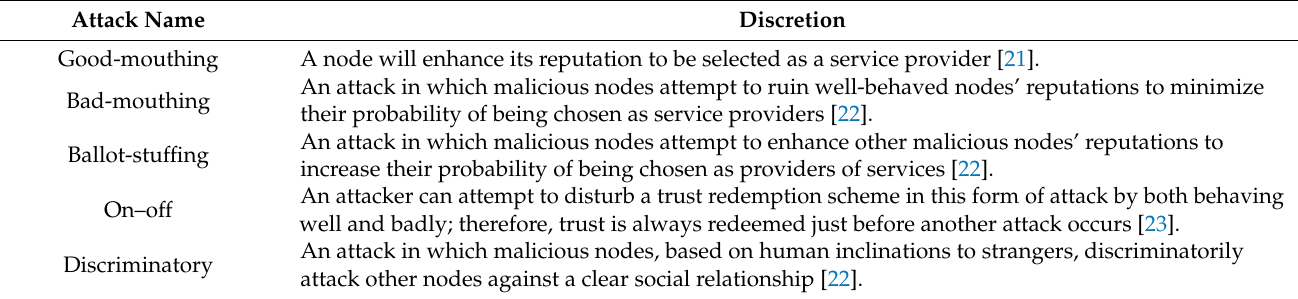
Table 1. Trust-related